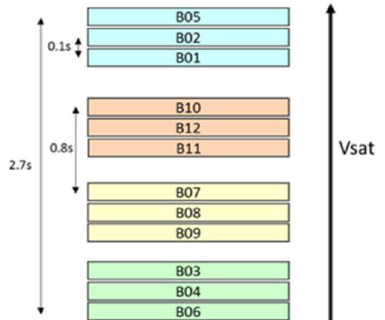
Figure 2. Venµs Bands Distribution Projected on Ground and Time Intervals